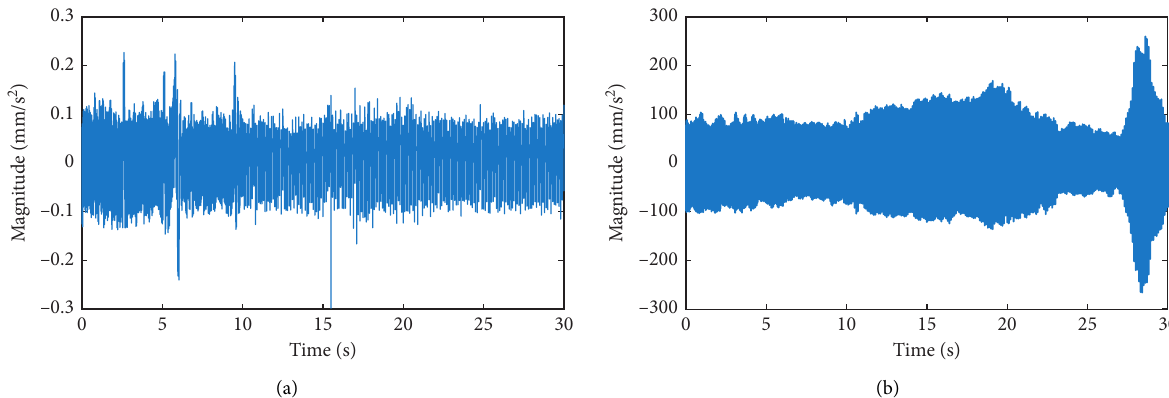
Figure 13: Acceleration signal analysis of the hollow blade in the machining process. (a) Stable machining (time domain). (b) Unstable machining (time